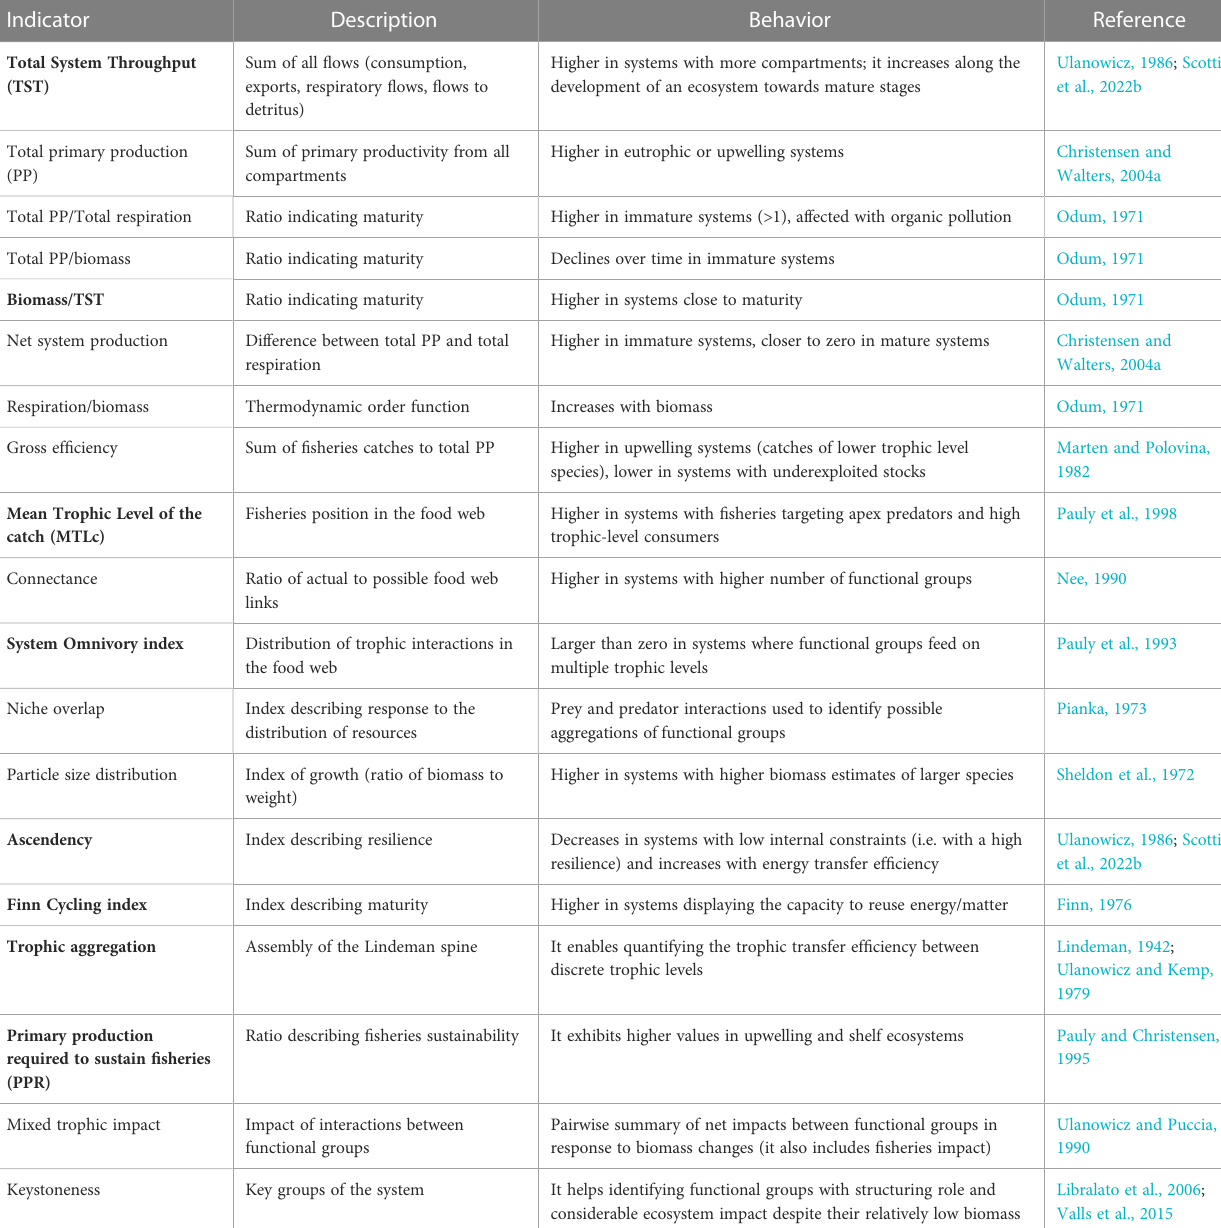
TABLE 1 Ecological indicators derived from the Ecopath module of the EwE software